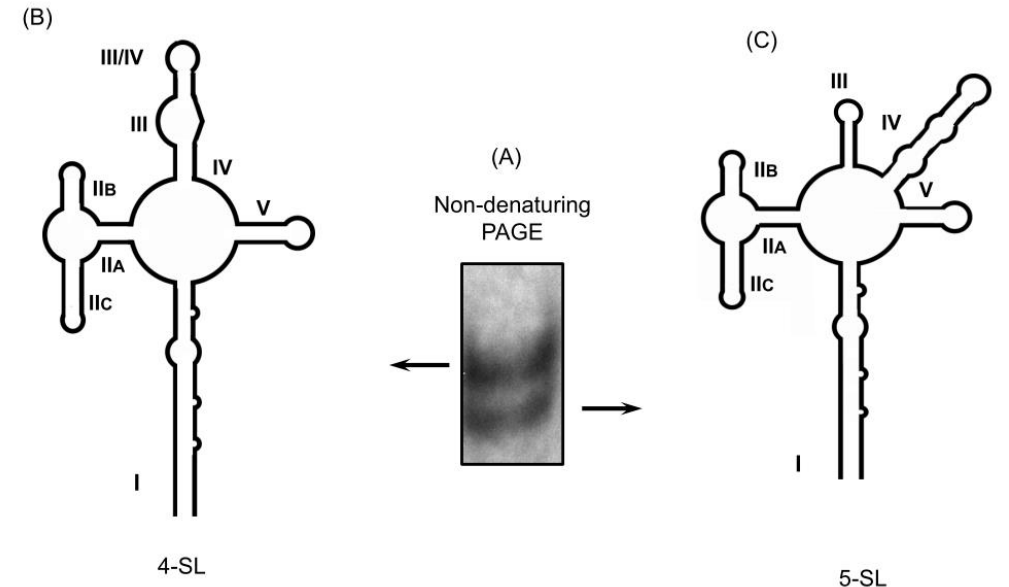
Figure 3. The HIV-1 RRE exists in a conformational equilibrium. ( A ) Following extended non-denaturing PAGE, slow and fast migrating RRE conformers were observed. Subjecting these RNAs to in-gel SHAPE defines these as 4 SL ( B ) and 5 SL conformers ( C ). Note that, despite their conformational heterogeneity, the topology of SL-II, the primary Rev binding suite, is preserved. Modified from Sherpa et al. [52]. The 232 nt HIV-1 RRE RNAs appended with a 3′ structure cassette were prepared for analysis by in vitro transcription.